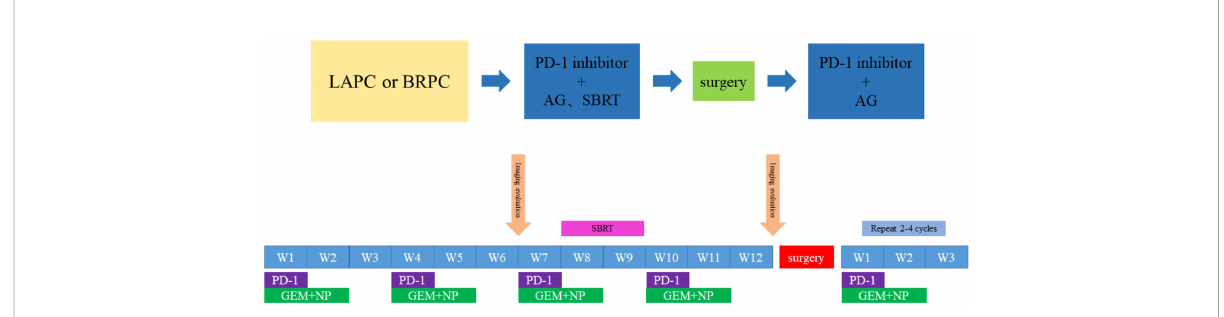
FIGURE 2 Timeline of the treatment. Every 3 weeks one cycle: Tislelizumab, (200 mg, on day 1), gemcitabine (1,000 mg/m 2 , on days 1 and 8) and nab- paclitaxel (125 mg/m 2 , on days 1 and 8); Radiotherapy: PTV:30Gy/10f;